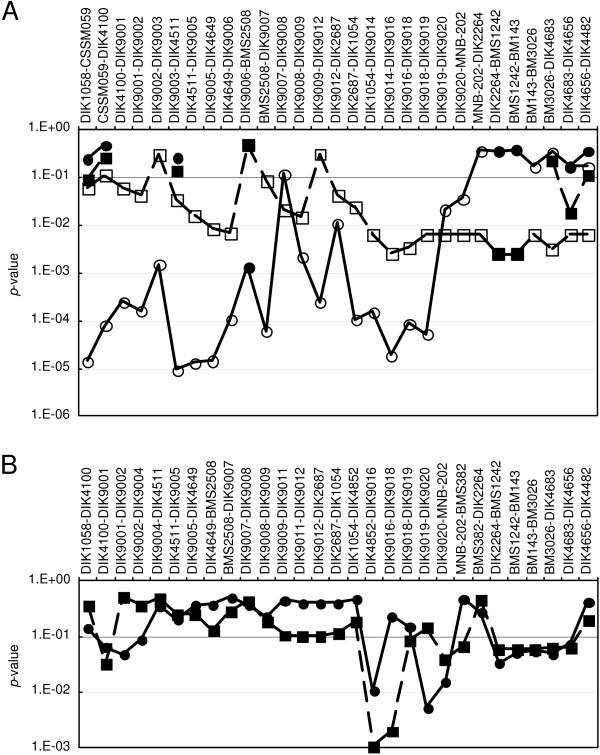
LD mapping using maternal alleles of the offspring in Japanese Black and Japanese Brown families. The average of slaughter year- and age-adjusted body or carcass weight was compared between the steers harboring two consecutive Q alleles in the maternal alleles and other steers using a t-test. The broken and solid lines indicate the p-values for the paternal Q- and q-inherited offspring, respectively. (A) Japanese Black Sire C family. Open and closed marks indicate the p-values for the Q1 and Q2 alleles, respectively. (B) Japanese Brown families of Sires D and E.